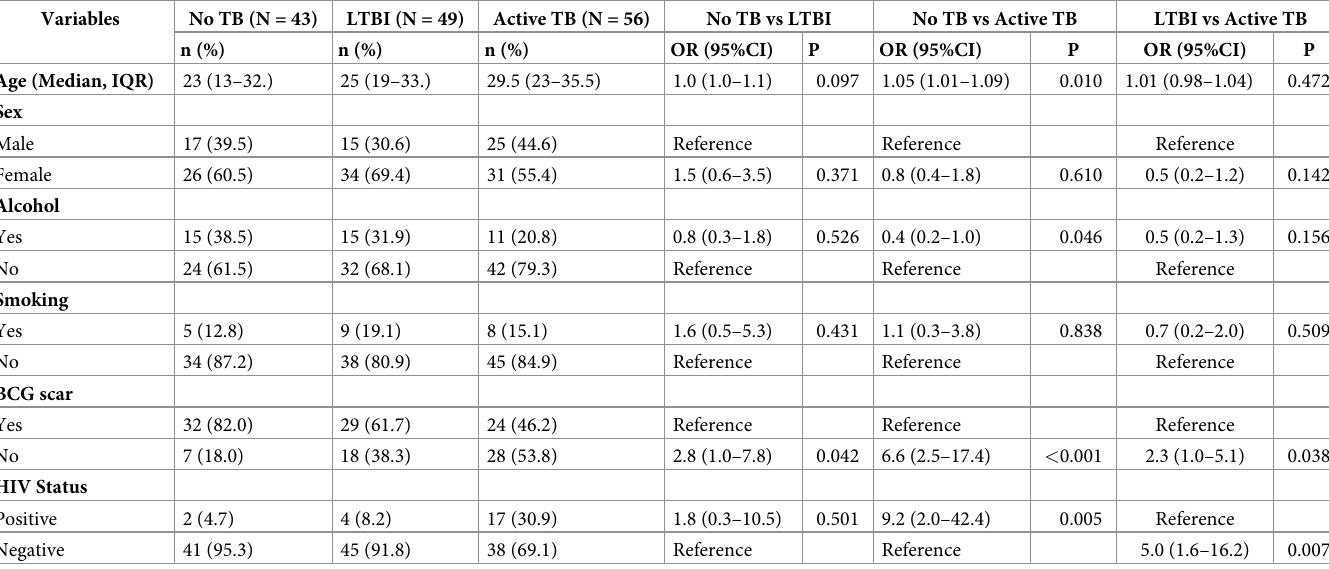
Table 1. Showing baseline characteristics of active TB patients’ latent TB individuals and those without TB infection.